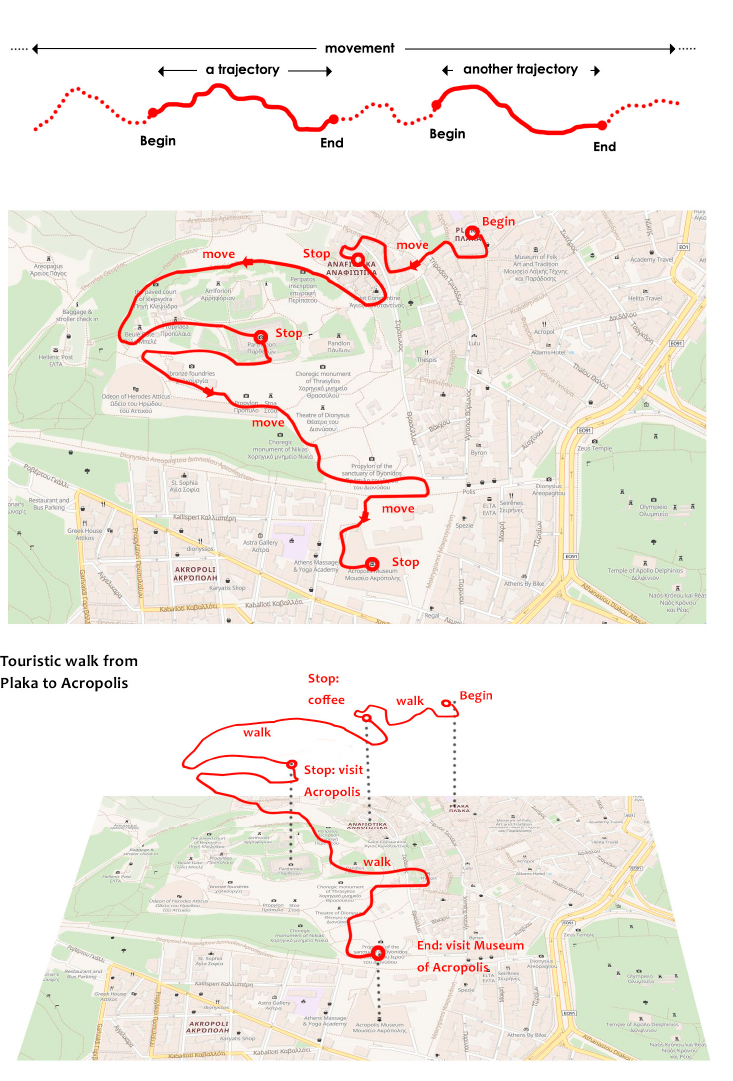
Figure 1. Example semantic trajectory depicting a tourist behaviour in Athens, starting from a simple trajectory, and resulting in a semantic trajectory.